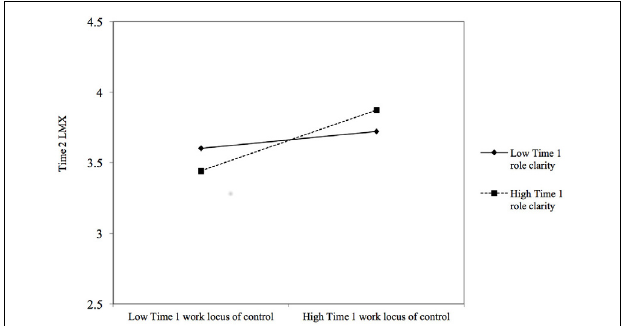
FIGURE 1 | Interaction between Time 1 work locus of control and Time 1 role clarity predicting Time 2 leader–member exchange (LMX), controlling for Time 1 LMX. Relationships are shown at 1 SD above and below the mean of Time 1 role clarity.